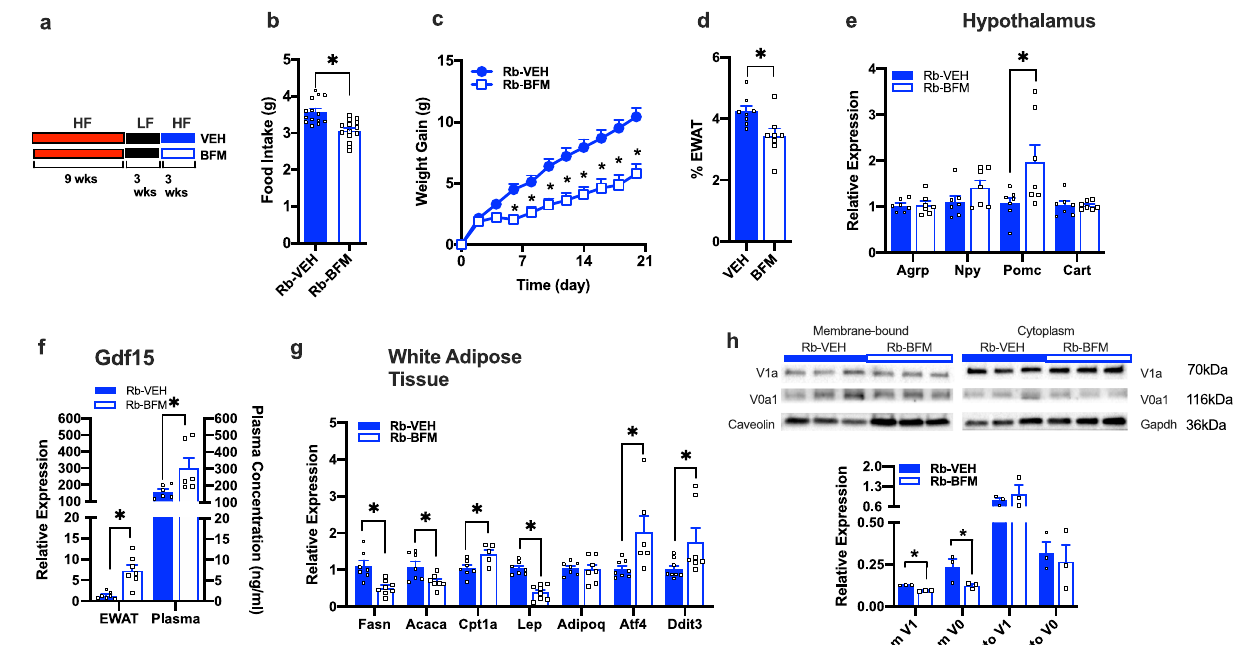
Fig. 7 | Inhibition of V-ATPase abrogates HFD-induced weight re-gain in for- merly obese mice. a Schematic diagram of weight rebound mouse experiment. b Average daily food intake ( t =4.31, df=26, p <0.001) and c HFD-induced weight re-gain ( n =14/group; group: F =18.29, df=1, p =0.002; time: F =119, df=10, p <0.001; genotype X time: F =13.78, df=10, p <0.001). d WAT as percentage of body weight ( n =8; t =2.74, df=14, p =0.01). e Relative gene expression in hypo- thalamus as determined by qPCR (Agrp: t =0.18, df=12, p =0.43; Npy: t =1.53, df=12, p =0.15; Pomc: t =2.27, df=12, p =0.04; Cart: t =0.04, df=12, p =0.96). f Gdf15 gene levels in WAT ( n =7/group; t =4.46, df=12, p <0.001) and plasma concentration( n =6/group; t =2.32,df=10, p =0.04). g Relativegeneexpressionin WAT (Fasn: t =3.93, df=13, p =0.001; Acaca: t =2.58, df=12, p =0.02; Cpt1a: